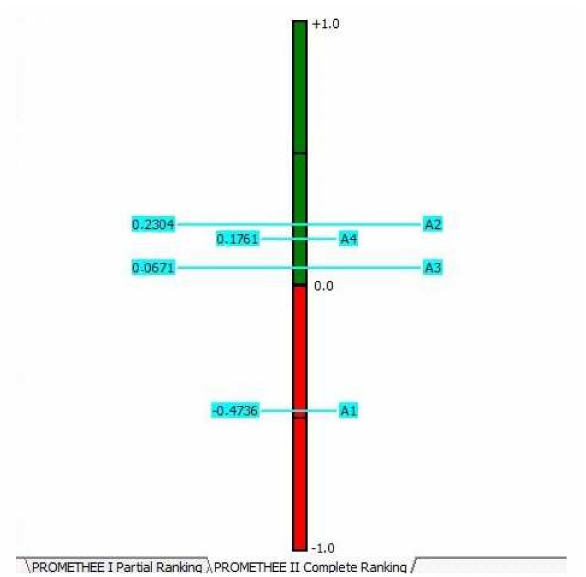
Figure 14. Complete ranking of alternatives based on the ROMETHEE II method, taking into consideration all categories of possible decisions (Mikro Derio quarry).